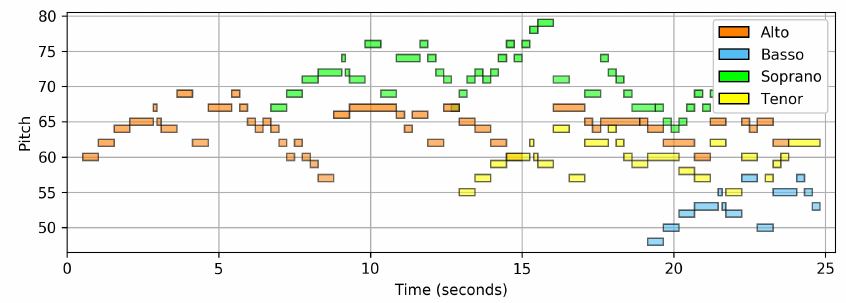
Figure 5. Visualization of a piano-roll representation generated by the FMP Notebook Symbolic Format: CSV . The figure shows the beginning of the four-voice Fugue BWV 846 in C major by Johann Sebastian